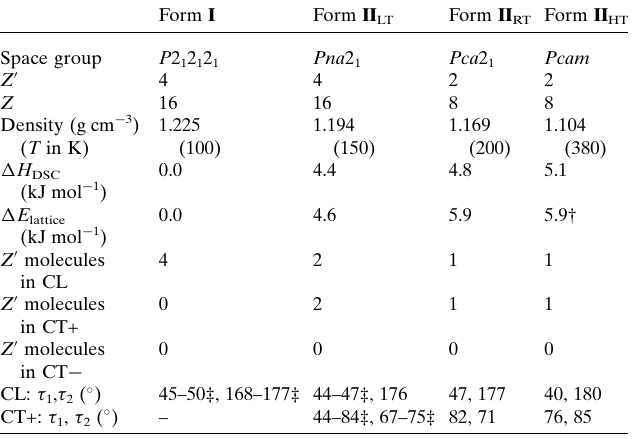
Table 2 Summary of key descriptors for the polymorphs and phases of